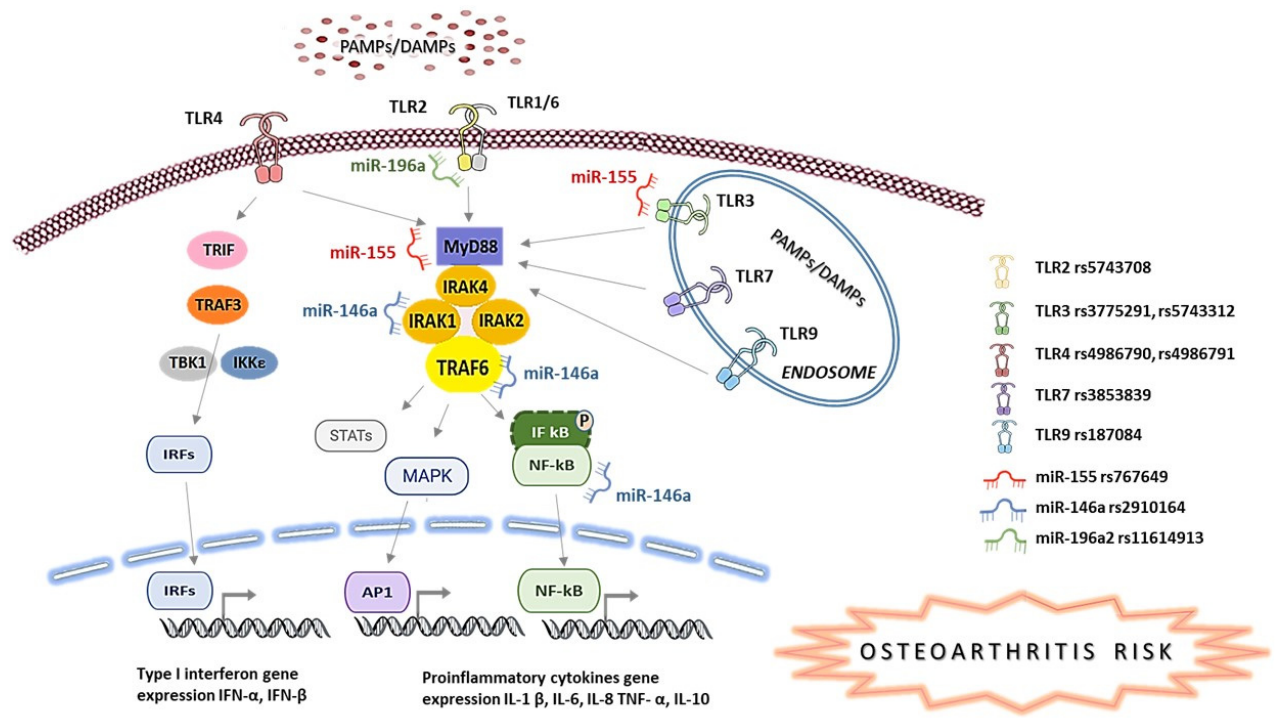
Figure 1. Schematic representation of the Toll-like receptor (TLR)-mediated signaling pathway. TLRs are controlled by several microRNAs, which, in addition to their role in the epigenetic regulation of gene expression, are ligands for TLR activation and downstream signaling. Genetic variations in the TLR and miRNA genes could influence cytokine production and susceptibility to osteoarthritis (OA). TLRs are indicated on the cell membrane (TLR4, TLR2, and TLR1/6) and endosomes (TLR3, TLR7, and TLR9) according to their distribution. Activation of the TLRs by PAMP/DAMP ligand binding initiates a complex signaling cascade. A MyD88-dependent signaling pathway activation results in the induction of NF- κ B, and AP-1 and the production of pro-inflammatory cytokines (IL-1 β , IL-6, and TNF- α ). The TRIF proteins mediate the activation of the type I interferons gene expression (IFN- α and IFN- β ). NF- κ B—Nuclear factor kappa-light-chain-enhancer of activated B cells;